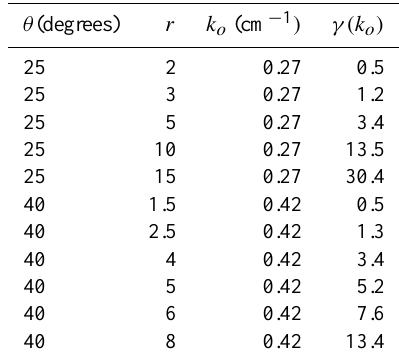
Figure 1. Layout of the numerical simulations.